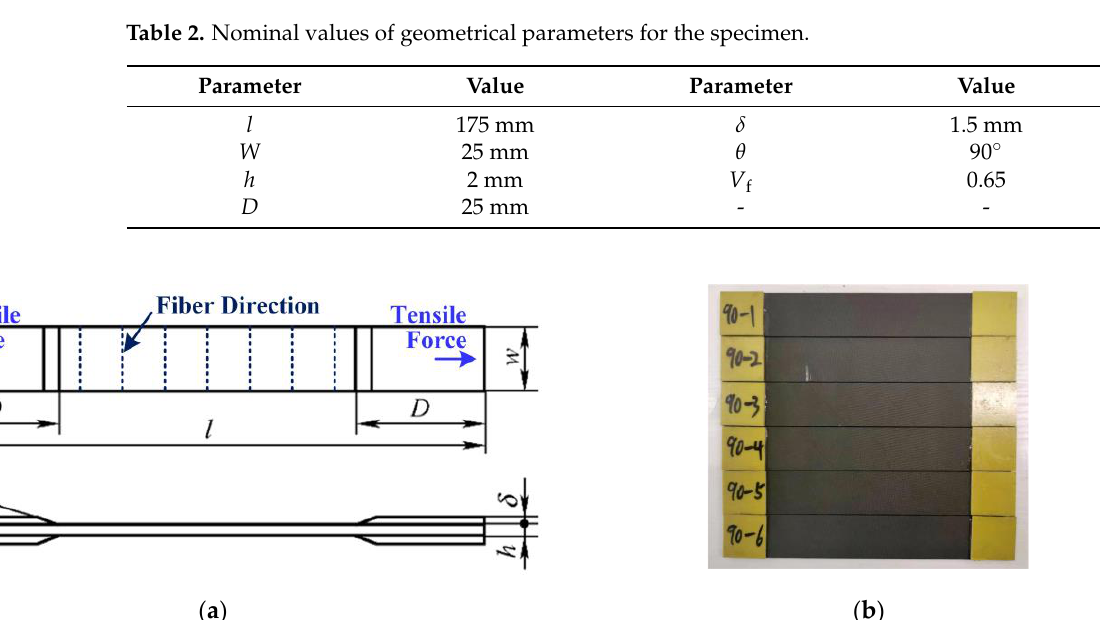
Figure 3. Specimen of 90° UD composite for transverse tensile loading test: ( a ) geometric design; ( b ) specimen photo. Table 2. Nominal values of geometrical parameters for the specimen.